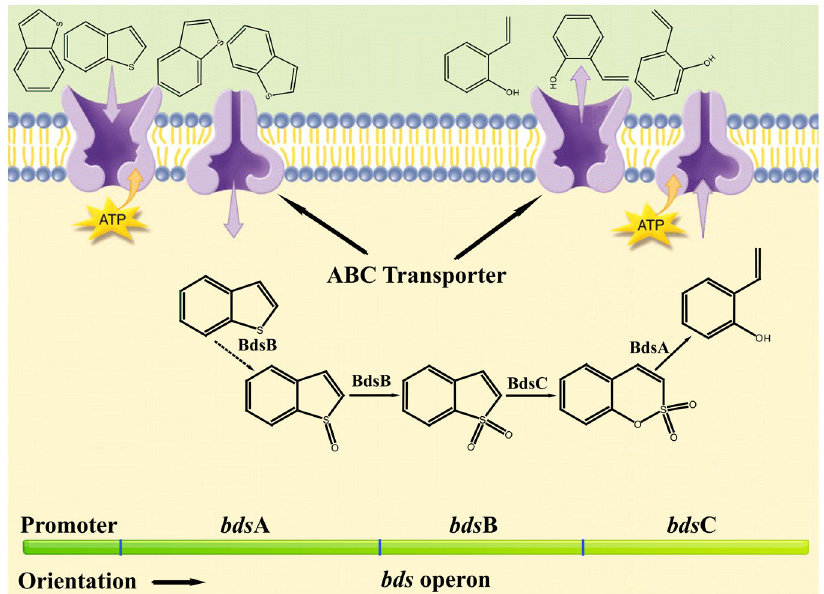
Figure 4. The proposed metabolism of BT for G. terrae strain